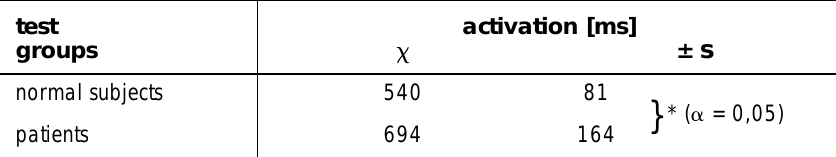
Table 2: Mean duration of activation in abduction of the arm.